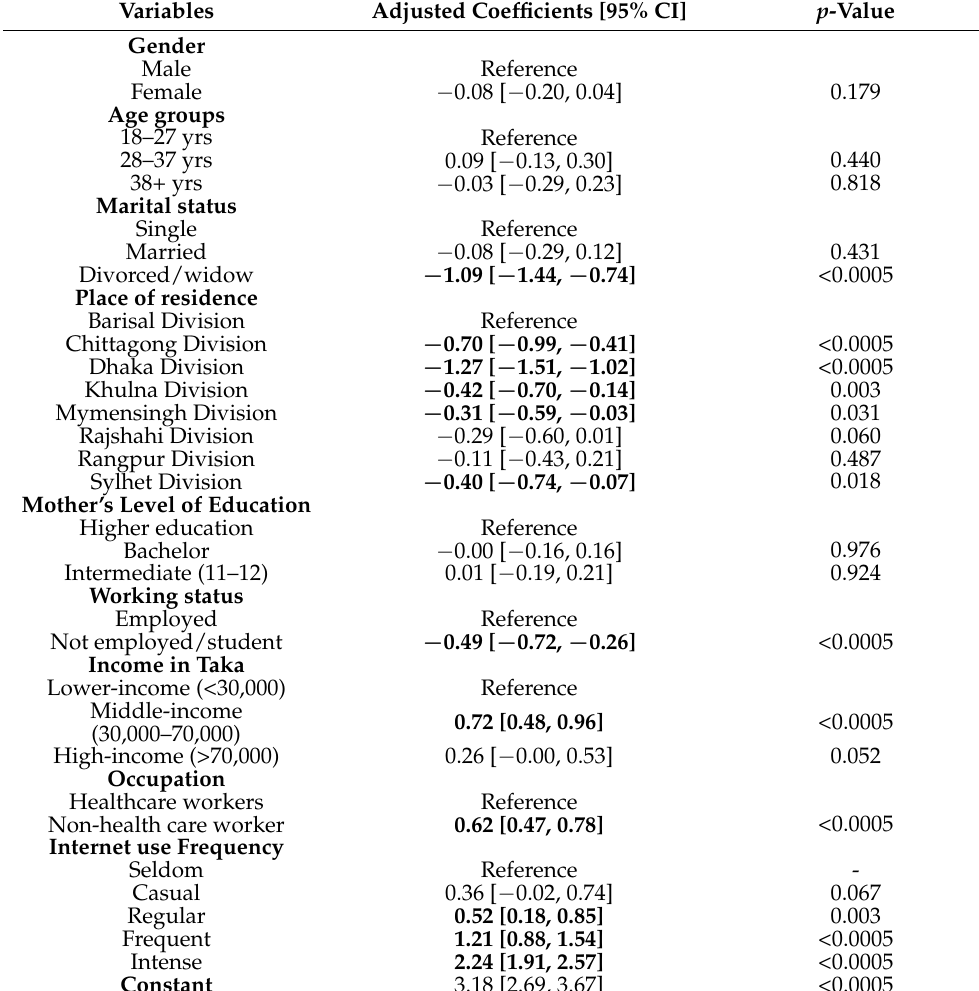
Figure 2. The impact of frequency of internet use on physical health scores: Unadjusted and adjusted coefficient and their 95% confidence intervals. Variables adjusted for were: gender, age group, division of residence, mother’s education, marital status, income, working status, occupation. Table 4. Results of multiple regression analyses predicting the level of physical complaints among internet users under COVID-19 lockdown. Printed in bolds are significant